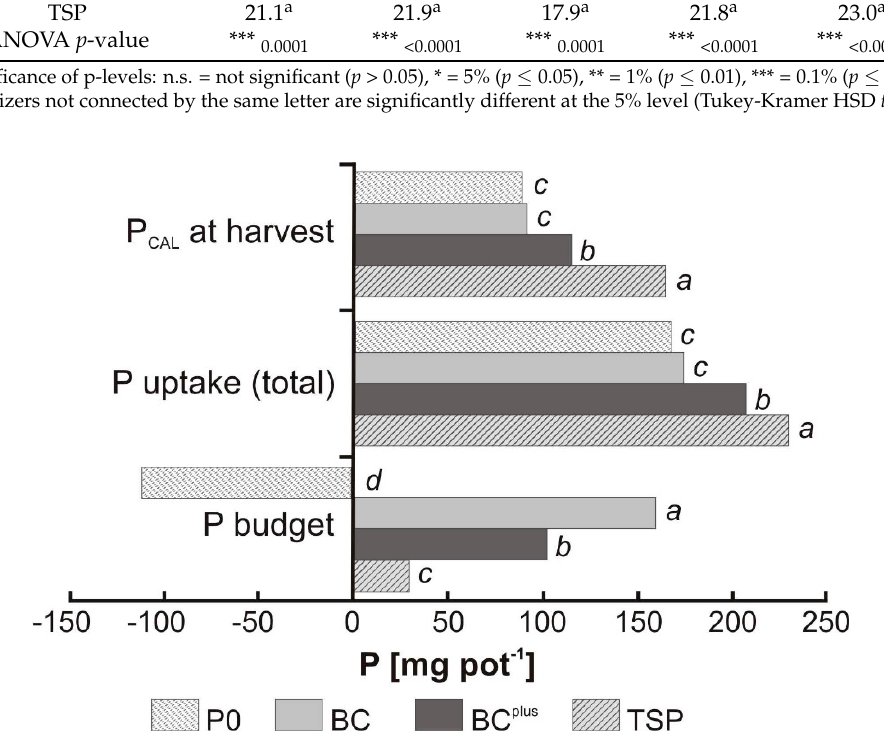
Fertilizer Treatment